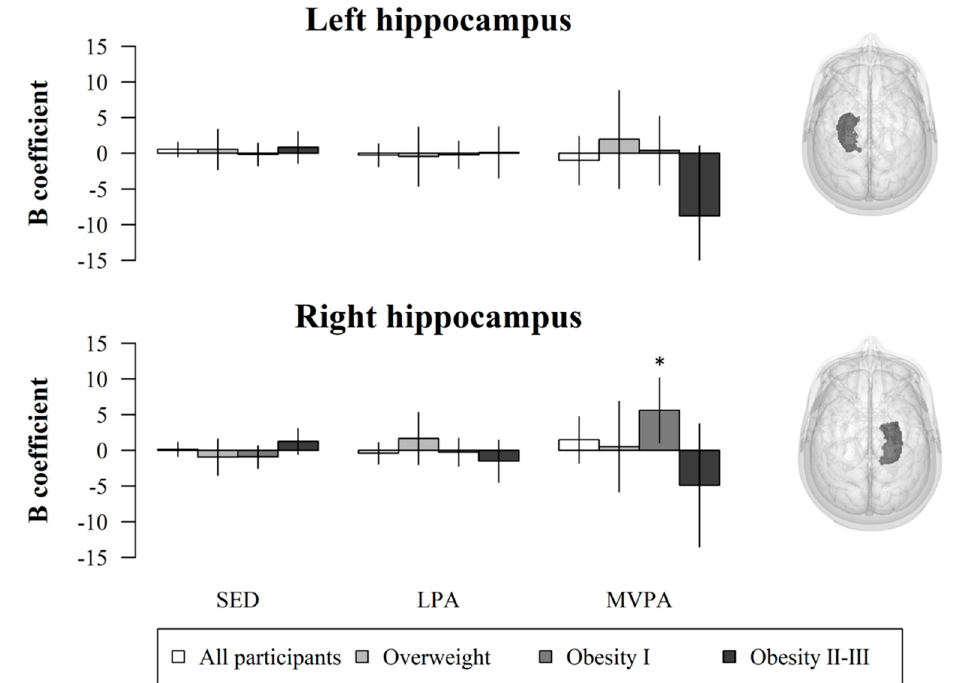
Figure 1. Regression non-standardized B coefficients and 95% confidence intervals (i.e., error bars) for the association of SED, LPA, and MVPA with GMV in the hippocampus adjusted for sex, peak height velocity, parental university level, and total brain volume. *Indicates statistical significance ( p < 0.05). SED: sedentary time; LPA: light physical activity; MVPA: moderate-to-vigorous physical